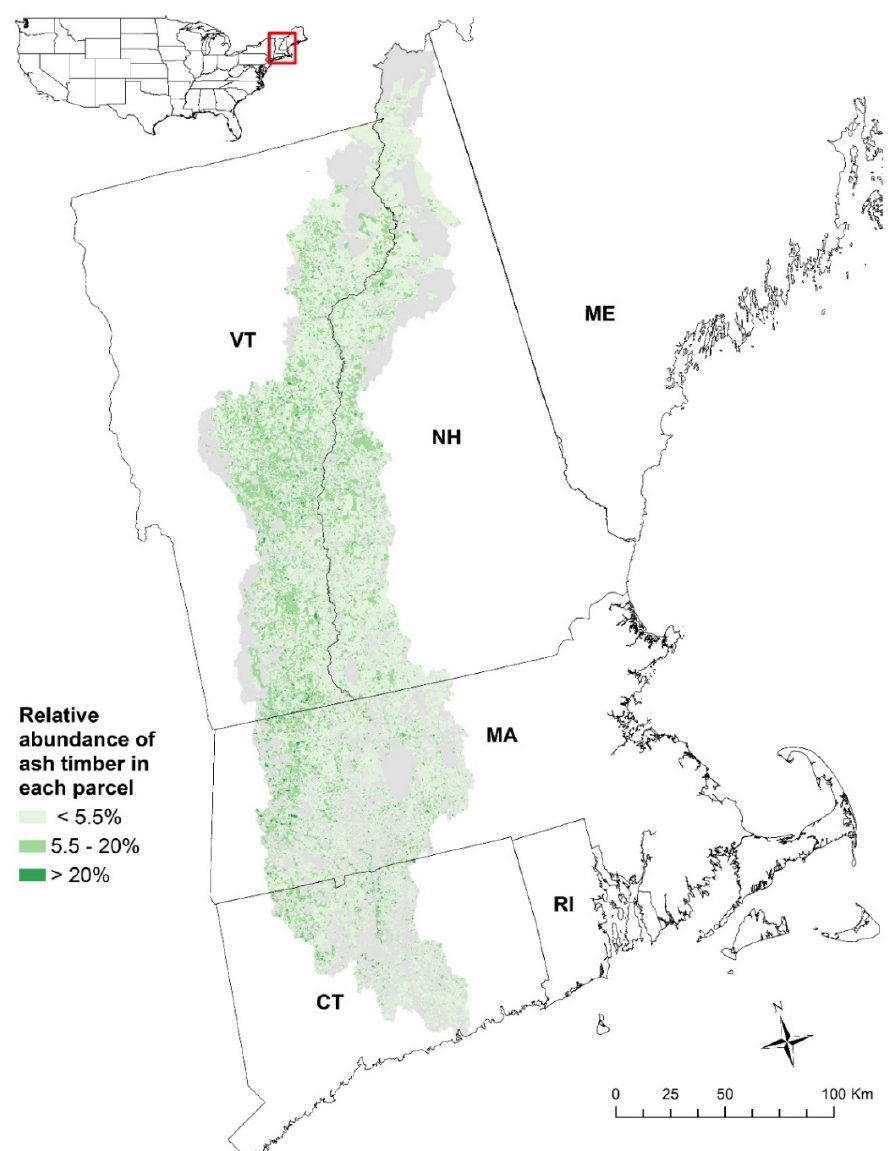
Figure 1. Relative abundance of merchantable ash in the Connecticut River Watershed of New England, USA. Overall, 49.5% of the parcels are classified as low relative abundance of ash, 40.8% are classified as medium, and 9.7% are classified as high. Grey areas represent non-family forest owner (FFO) parcels or FFO-parcels without ash. Inset indicates study location within northeastern United States.